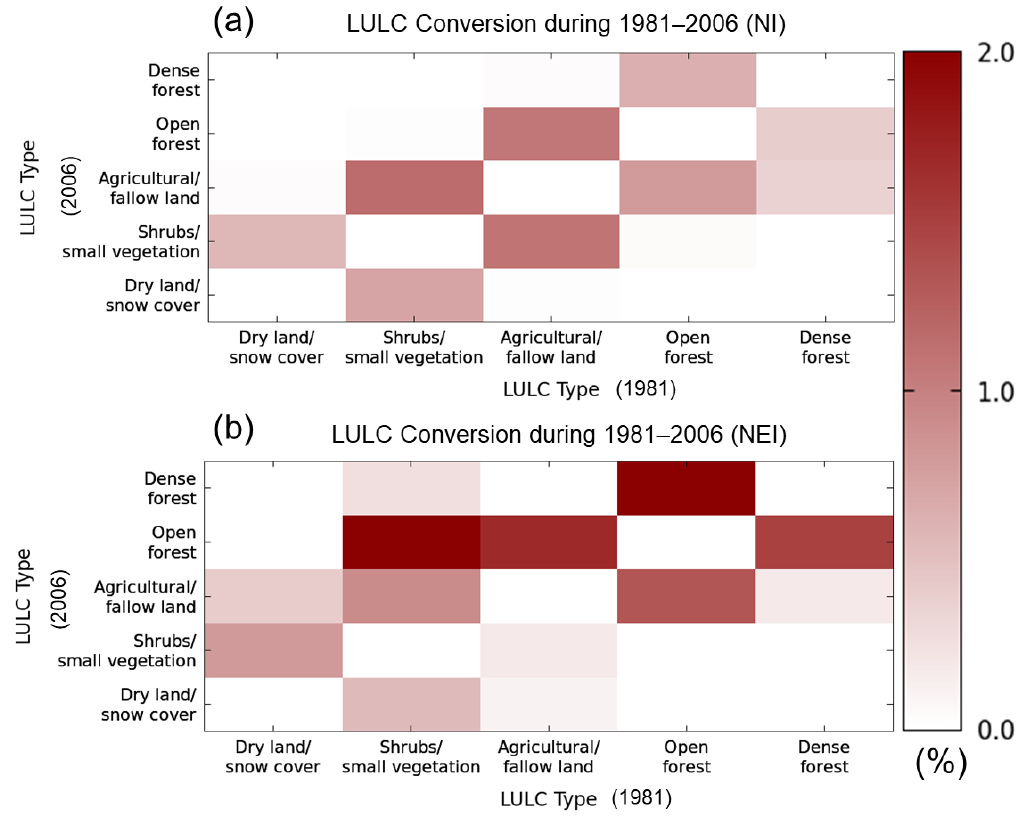
Figure 7. LULC change matrix analysis (in %) during 1981–2006 over ( a ) NI and ( b ) NEI. Conversion direction is from 1981 to 2006.